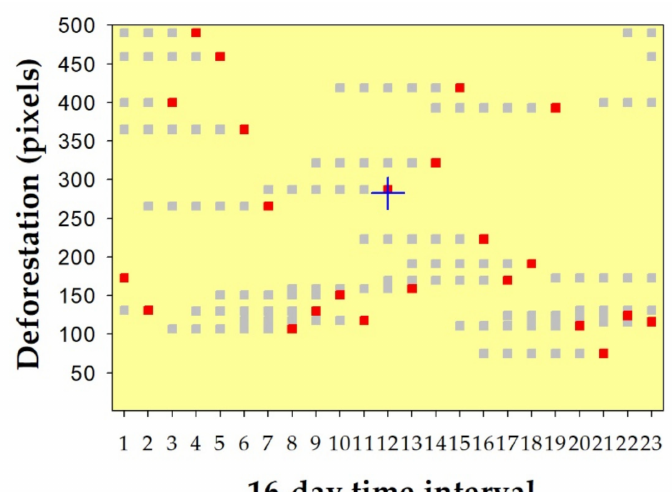
Figure 7. A hypothetical reference deforestation time-series (red squares) was shifted to the left from 16 days to 80 days (grey squares)—representing an acceleration of detection—to perform sensitivity analyses of the proposed method in terms of its robustness to measure the similarity of temporal patterns. The blue cross is the centroid of the graph.